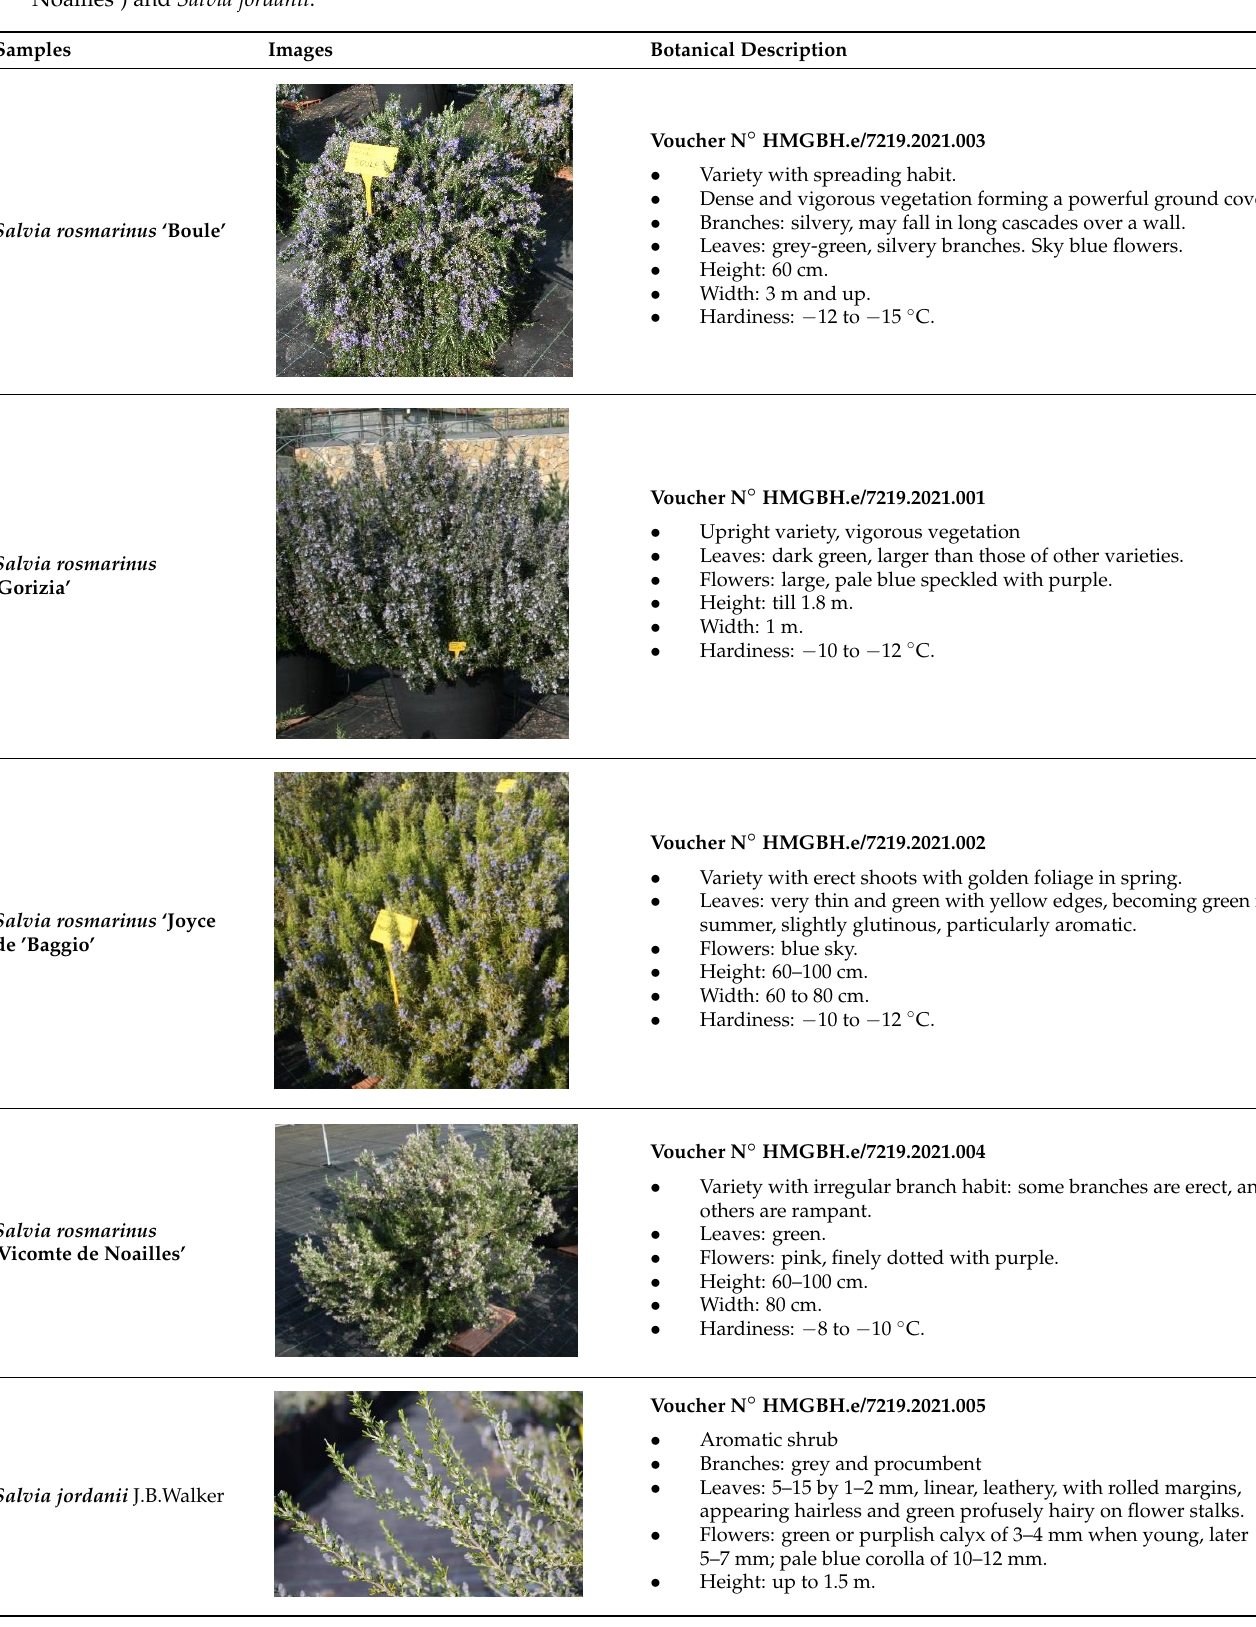
Table 6. Botanical description of the four Salvia rosmarinus cultivars ( ‘Boule’; ‘Gorizia’; ‘Joyce de Baggio’; ‘Vicomte de Noailles’ ) and Salvia jordanii.